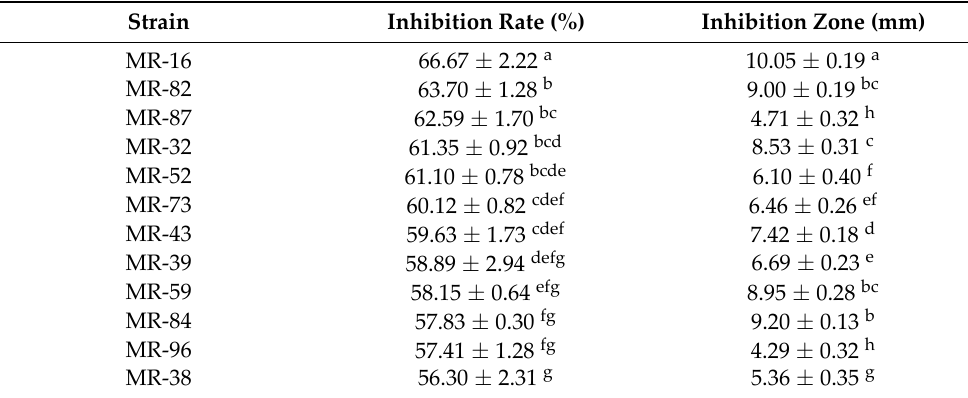
Table 1. Antifungal activities of selected rhizospheric fungi against F. oxysporum